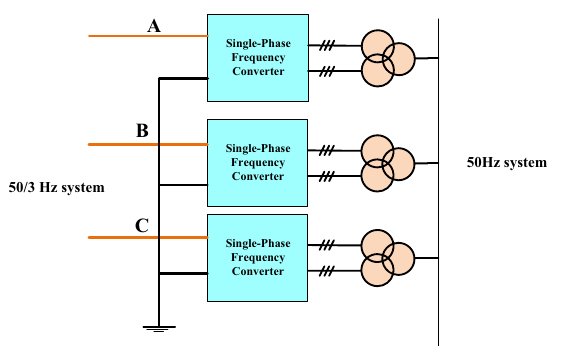
Fig. 17 Topology of the cycloconverter